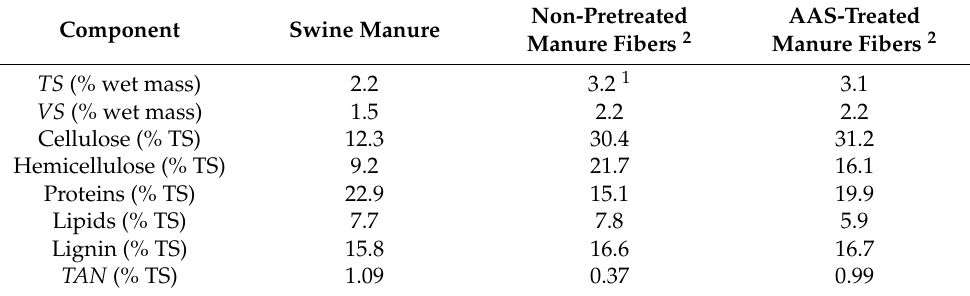
Table 1. Composition of manure and non-pretreated (NP) and aqueous ammonia soaking (AAS)- treated fibers used in this study.